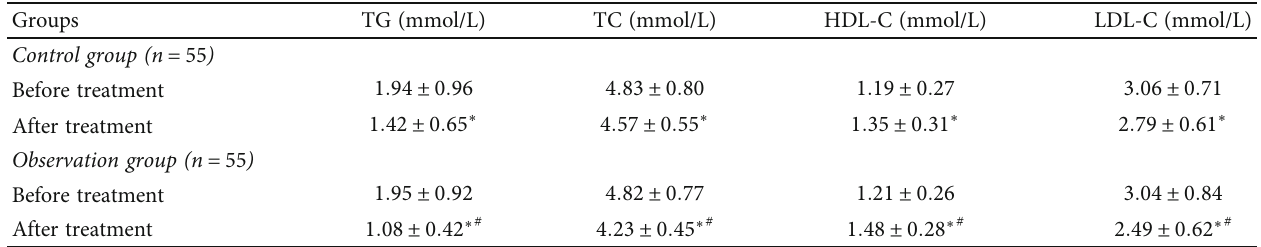
Table 4: Levels of blood lipid indices tested before and after treatment in both groups.